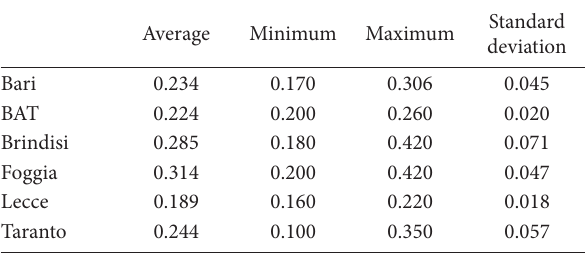
Table 3. Durum wheat yields (tons/hectare) among Apulian prov-